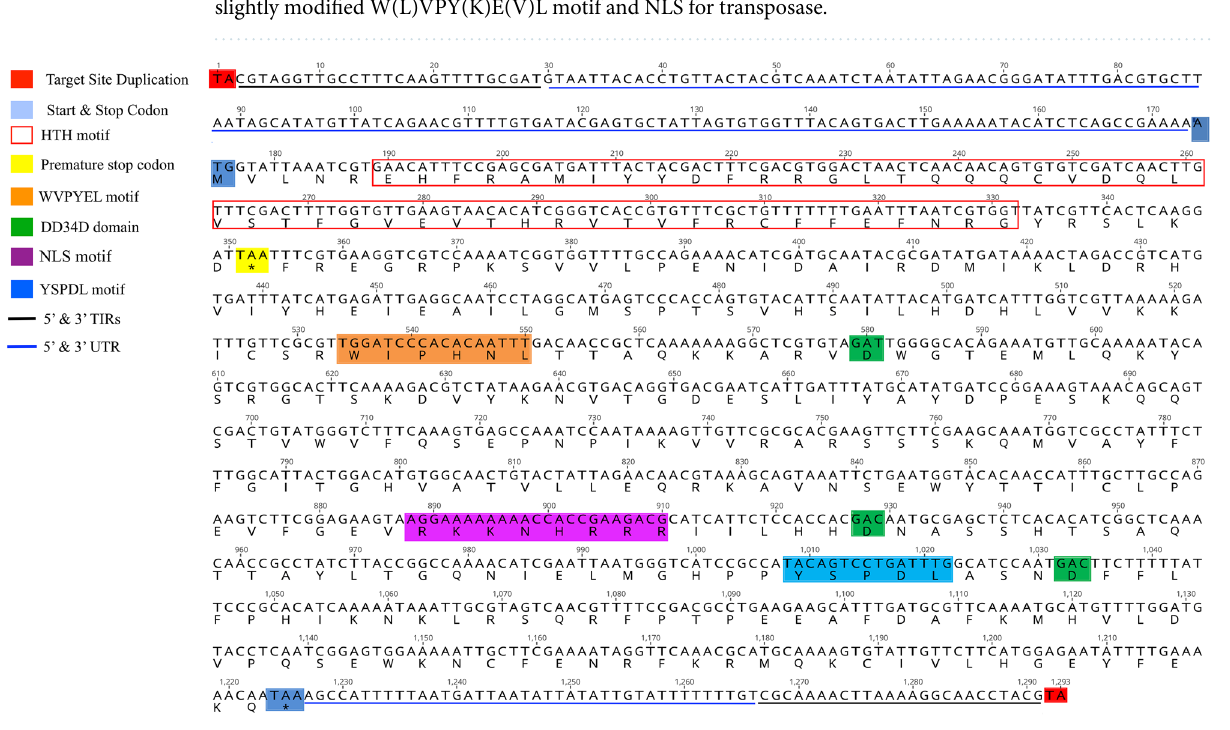
Figure 4. Full length sequence of MLE ( Mrmar18 ) from Vertumana subfamily in Melaphis rhois with a premature stop codon and slightly modified WV(I)PY(H)E(N)L motif and NLS for